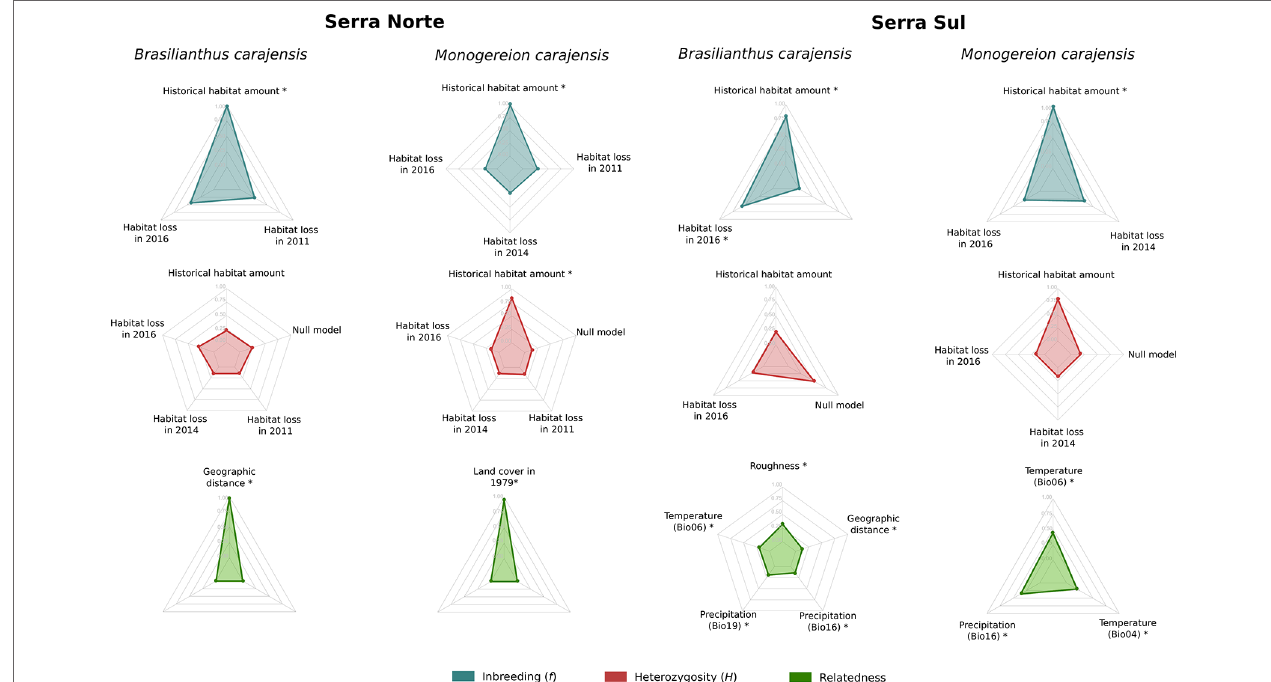
FiGURE 3 | Relative variable importance in the set of best-fitting models (ΔAIC ≤ 2) for Brasilianthus carajensis and Monogereion carajensis in Serra Norte and Serra Sul (see Materials and Methods and Supplementary Tables S3 and S5 for details). Individual-level genetic diversity metrics ( H and f ) were response variables and habitat amount in 1979 and habitat loss in 2011, 2014, and 2016 were predictors in genetic diversity models. Pairwise inter-individual genetic relatedness was the response variable and resistance distances computed from optimized surfaces were predictors in isolation by resistance models. Likelihood Ratio Test (LRT) were performed to assess if each predictor variable significantly improved the model’s log-likelihood (significant variables are highlighted with